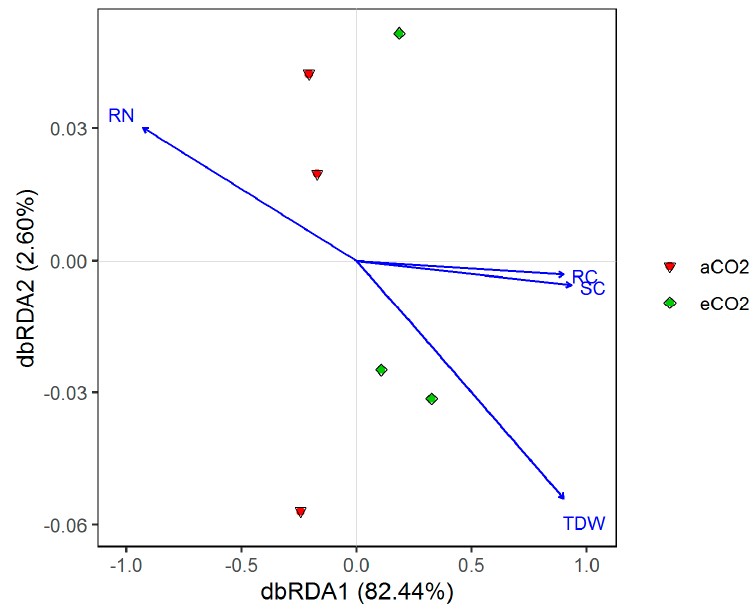
10 ‐ methyl, 17:0 10 ‐ methyl, 18:0 10 ‐ methyl, 17:1 ω 7c 10 ‐ methyl and 18:1 ω 7c 10 ‐ methyl. The ratio of fungal to bacterial are defined as the sum of fungal PLFAs to the sum of PLFAs for gram negative, gram positive and actinomycetes. The error bars represent the standard deviation of the three parallel measurements. And the sample size (N) was three. Agronomy 2020 , 10 , x FOR PEER REVIEW